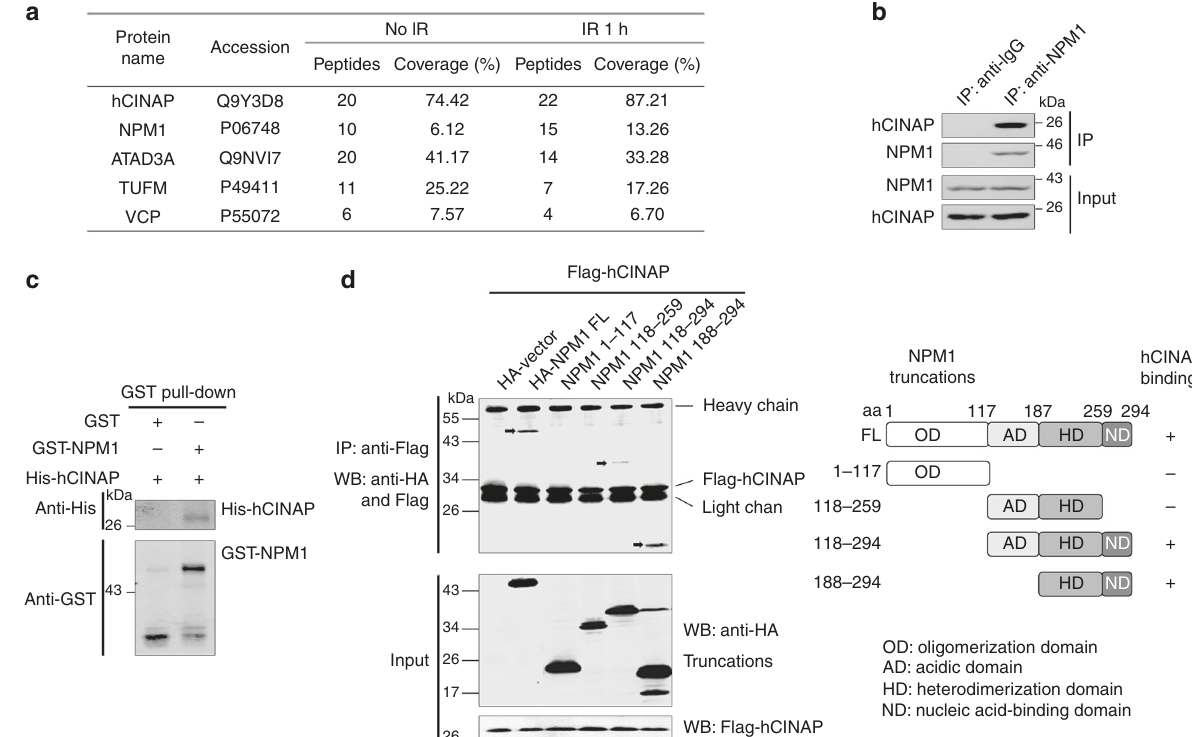
Fig. 2 NPM1 is a new partner protein of hCINAP. a HEK293T cells harboring the Flag-empty vector or Flag-hCINAP were treated with or without IR (6 Gy) and then lysed and subjected to af fi nity puri fi cation using anti-Flag M2 af fi nity beads. The puri fi ed protein complex was analyzed by mass spectrometry. The major hits from mass spectrometry are shown in the table. b The interaction between endogenous hCINAP and NPM1 in HEK293T cells was con fi rmed by co-IP assays. Whole-cell lysates were immunoprecipitated with an antibody against NPM1 followed by immunoblotting using the indicated antibodies. c His-hCINAP and GST-NPM1 proteins were puri fi ed from E. coli , and in vitro pull-down analysis was performed using the GST protein as a negative control. d Mapping of the interaction domain of NPM1 with hCINAP. HEK293T cells expressing the Flag-hCINAP, HA-NPM1 WT, or NPM1 truncated mutants were subjected to the co-IP assays. A schematic of the different truncated mutants of NPM1 is shown. The source data can be found in Supplementary Data 1. Unprocessed scans of blots are provided in Supplementary Fig.